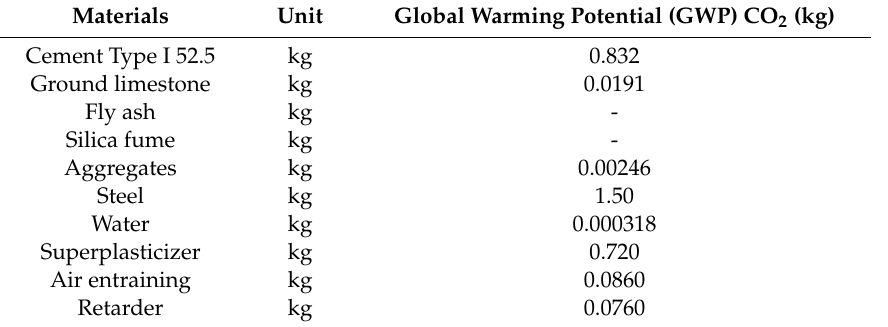
Table 2. The environmental impact of the components of reinforced concrete (RC) structures